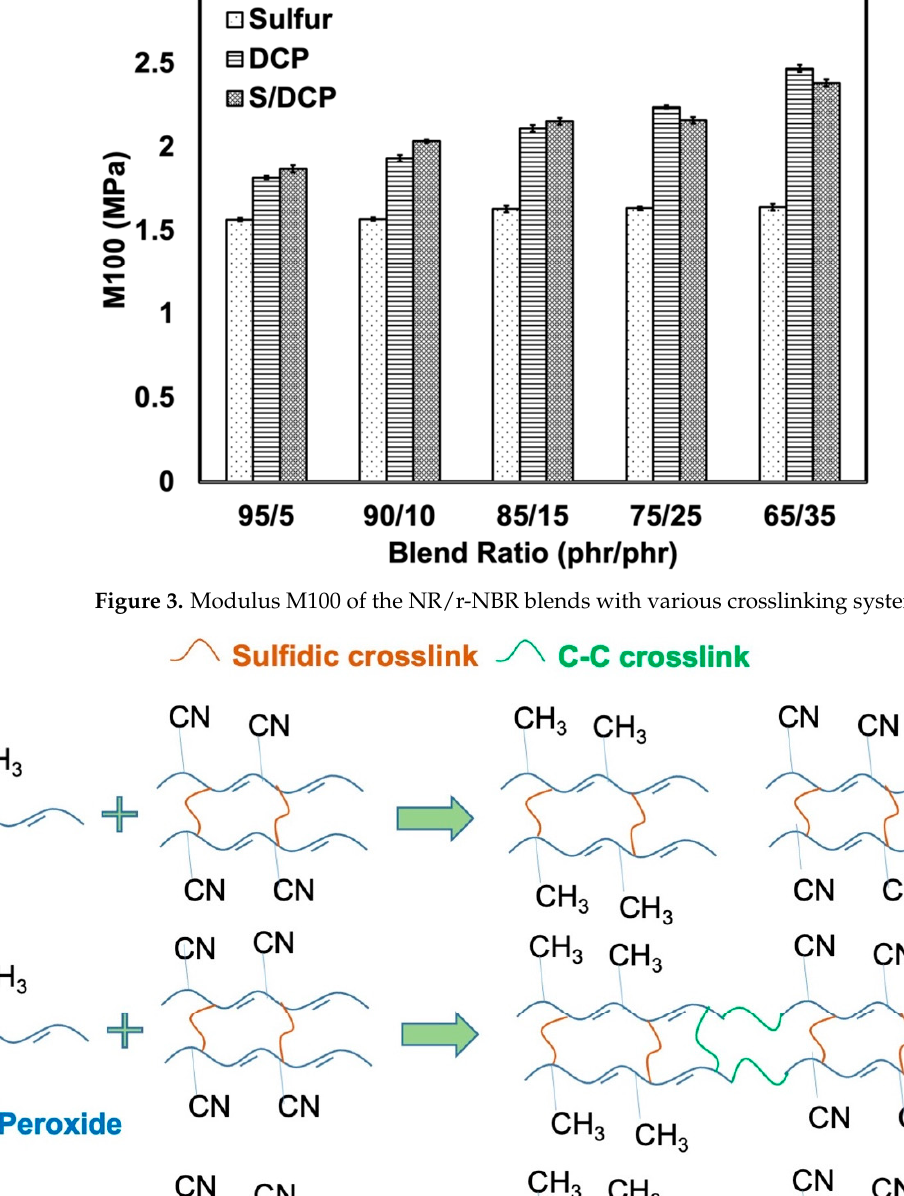
Figure 2. Tensile strength of NR/r-NBR blends prepared with various crosslinking systems.